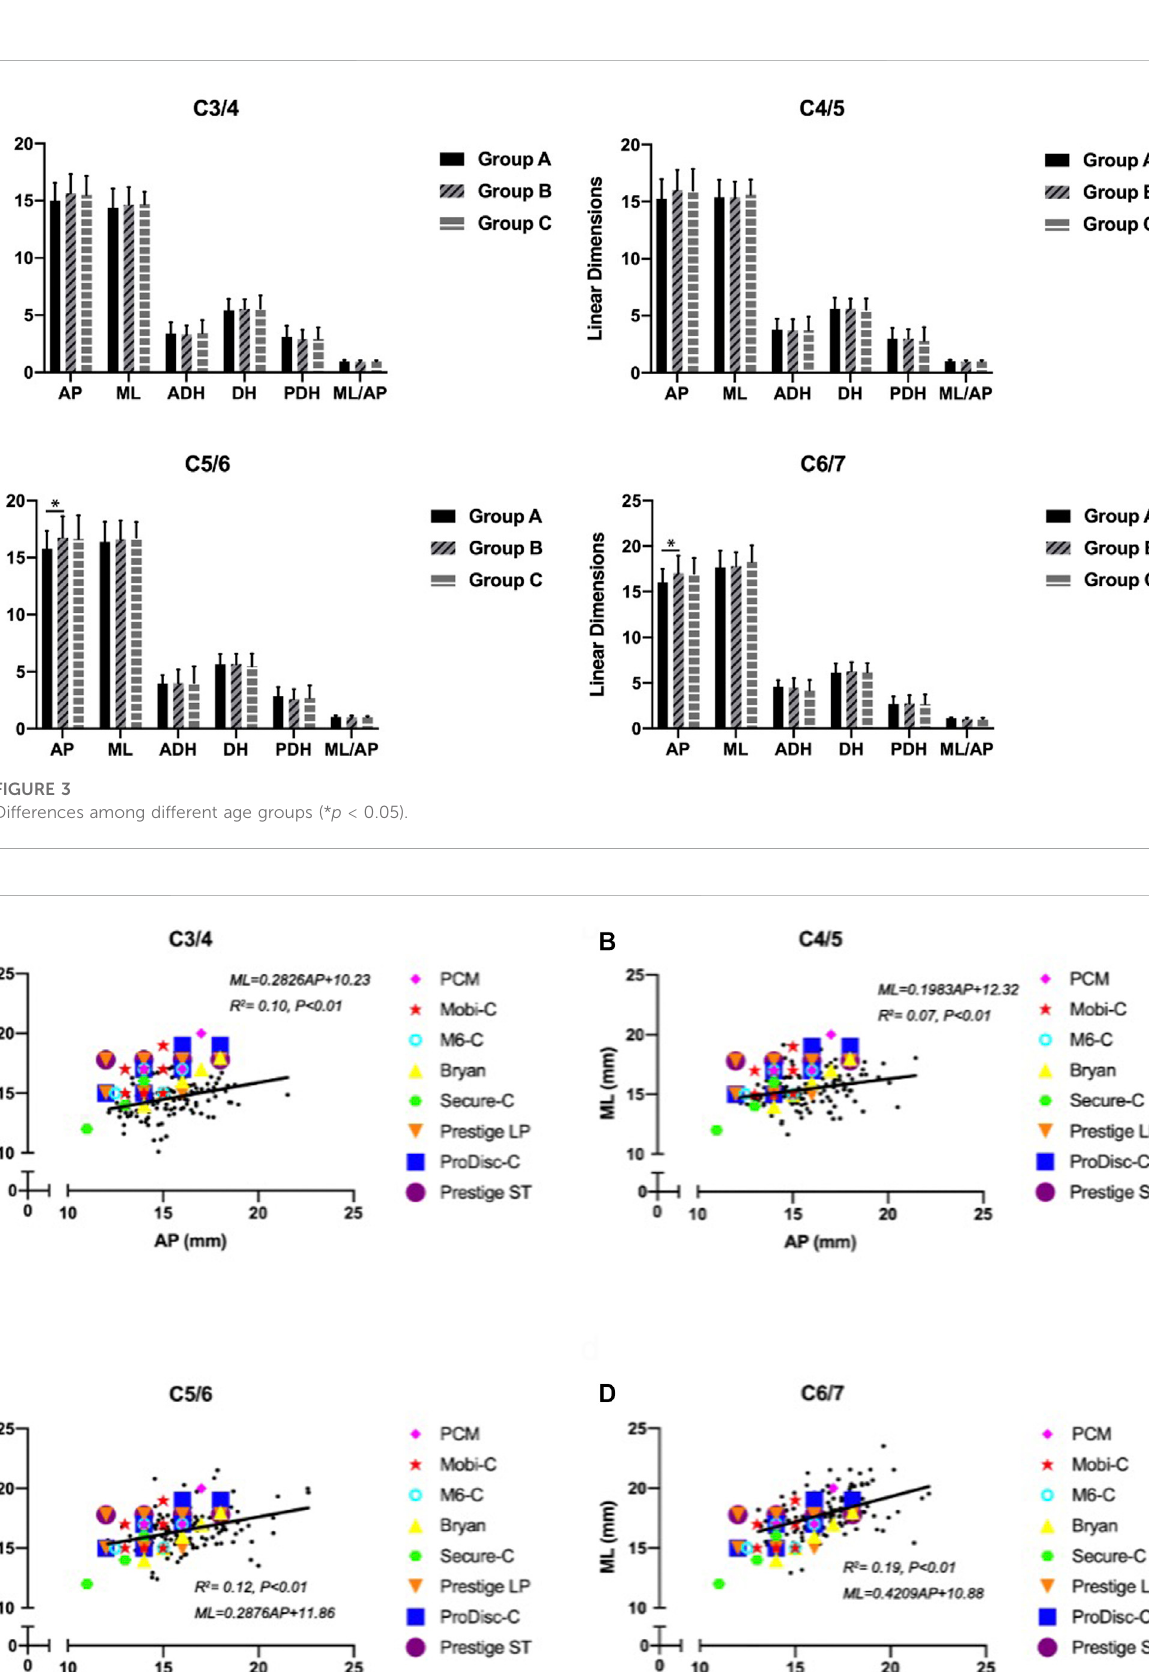
Frontiers in Bioengineering and